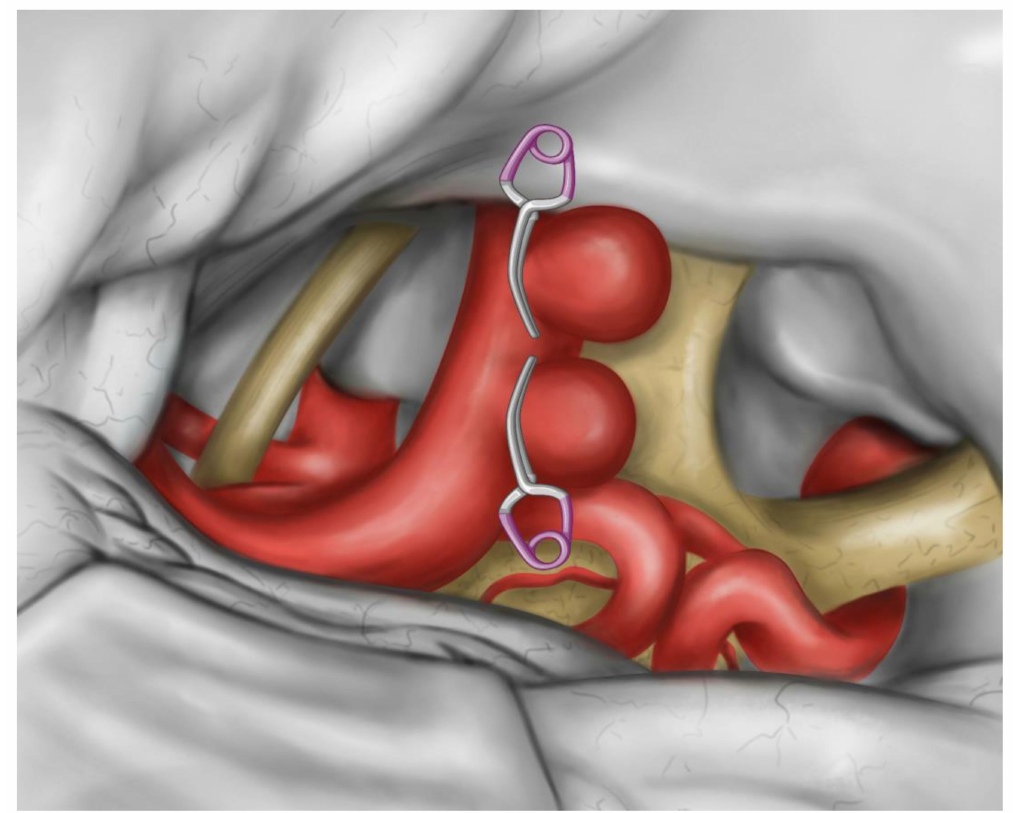
Figure 3. A sketch of counterclipping in the “facing”